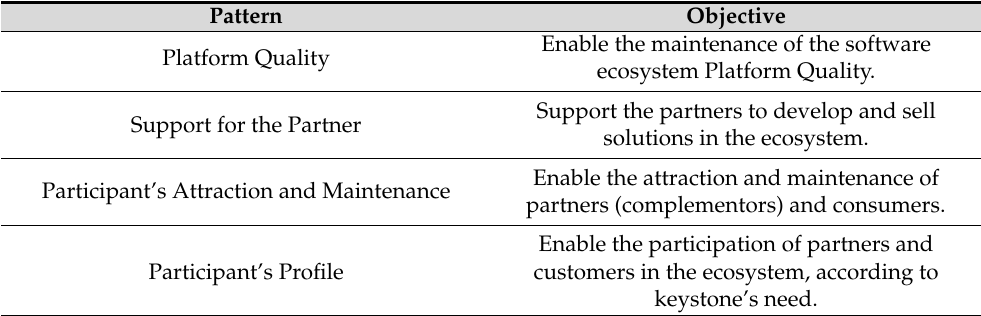
Table 7. Strategic pattern’s